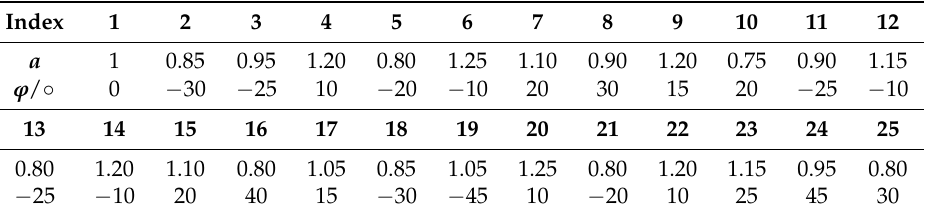
Table 2. Gain–phase error